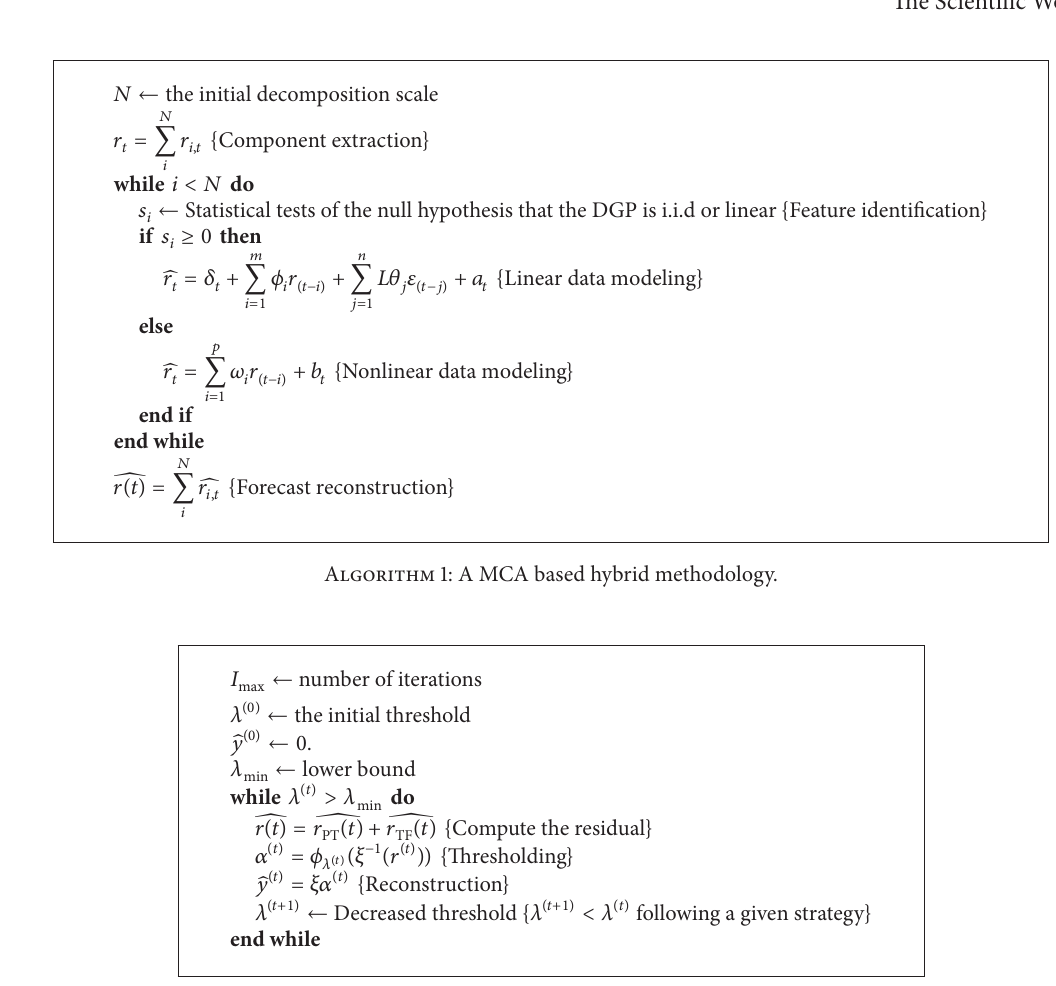
Algorithm 2: Iterative thresholding algorithm for